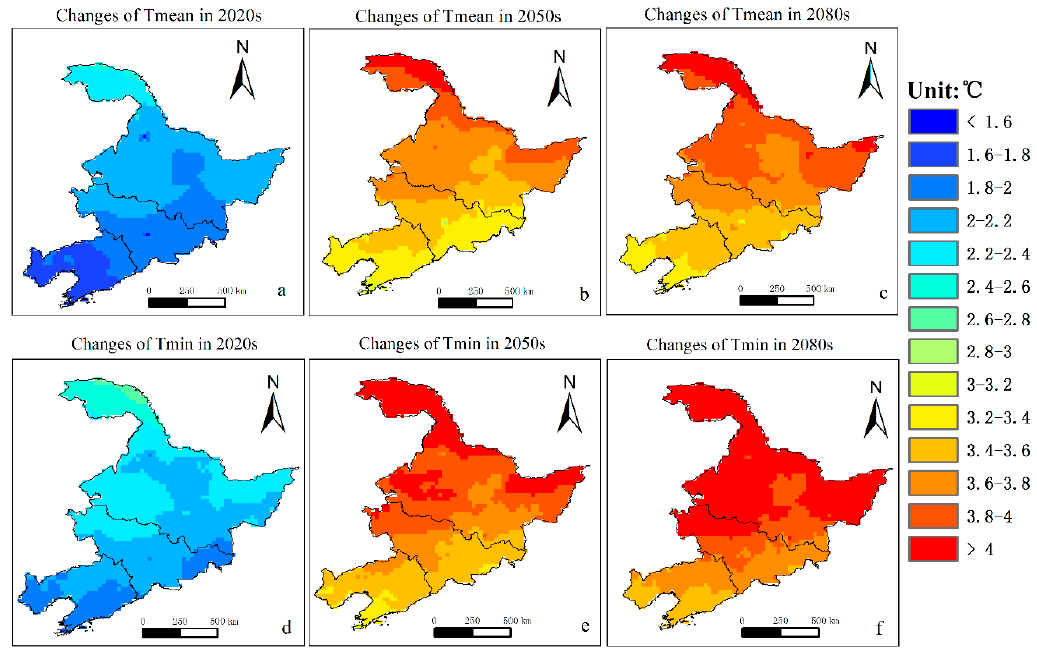
Figure 5. Changes of T mean and T min compared with the baseline period over the 21st century: ( a ) changes of T mean in 2020s; ( b ) changes of T mean in 2050s; ( c ) changes of T mean in 2080s; ( d ) changes of T min in 2020s; ( e ) changes of T min in 2050s; and ( f ) changes of T min in 2080s.